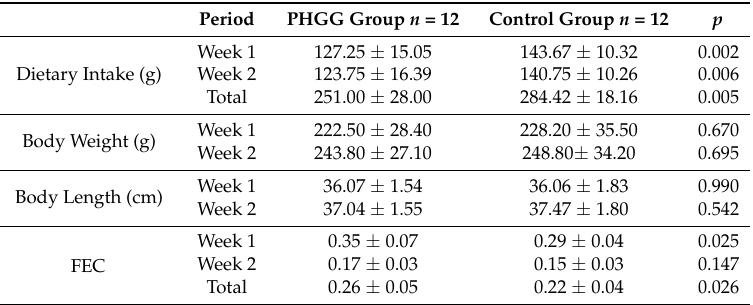
Table 2. The dietary intake, weight, and feed efficiency coefficient (FEC) in the different study periods of the animals in the partially hydrolyzed guar gum (PHGG) and control